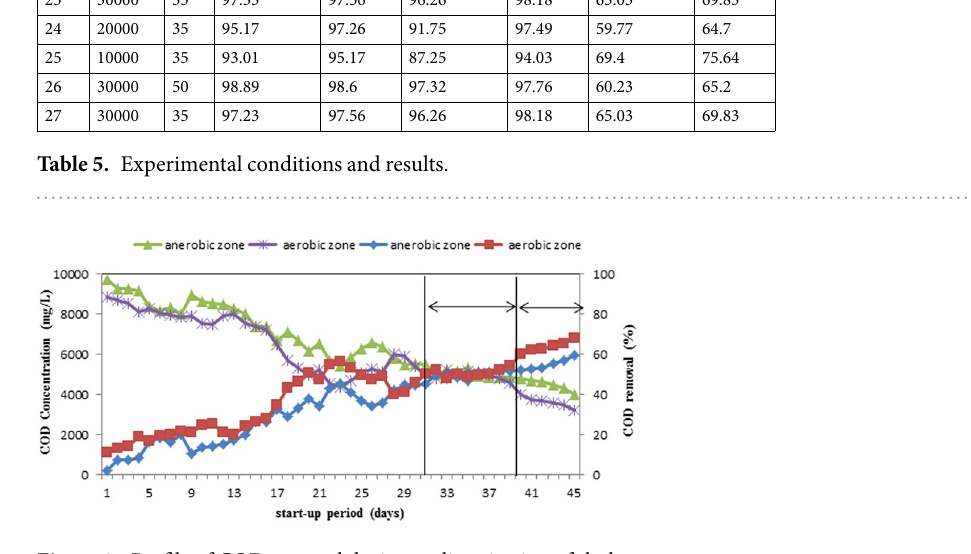
Figure 2. Profile of COD removal during acclimatization of